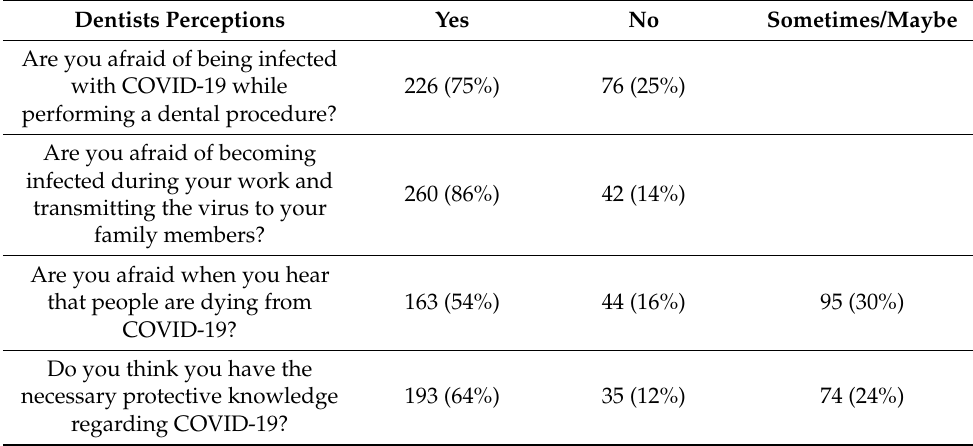
Table 2. Dentists’ perceptions of the COVID-19